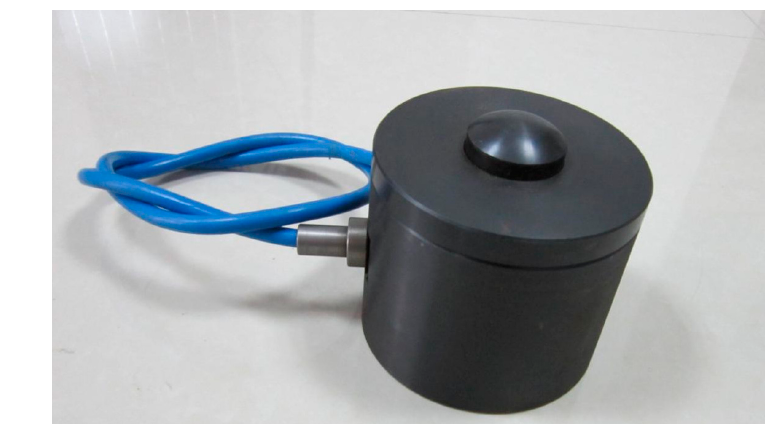
Figure 9. Meters’ layout. 4.2. Floor failure Depth (FFD) Detecting Equipment and Detecting Method